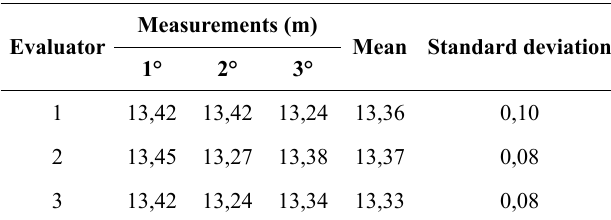
the displacement rat.